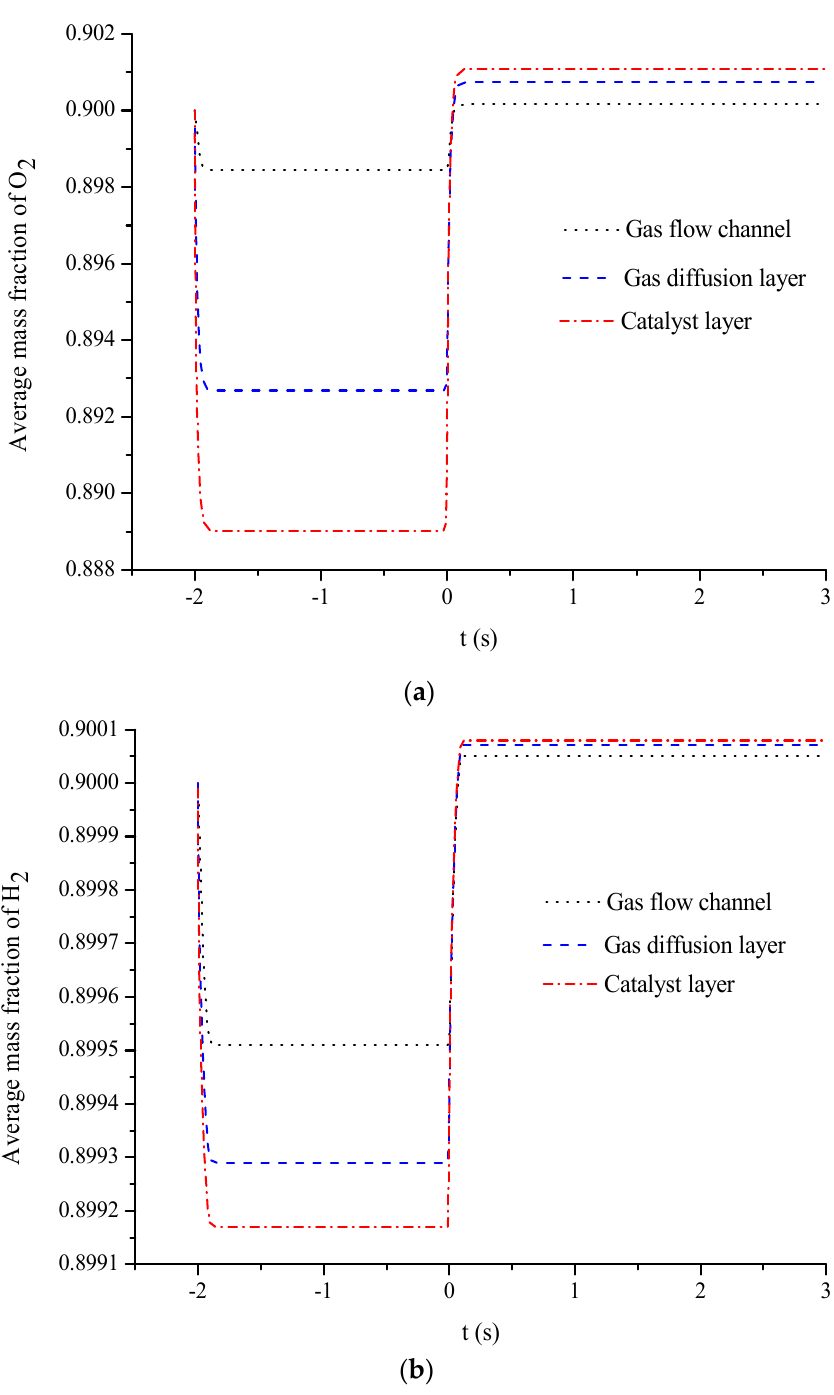
Figure 8. ( a ) Time-dependent evolution of O 2 mass fraction in different layers; ( b ) Time-dependent evolution of H 2 mass fraction in different layers.